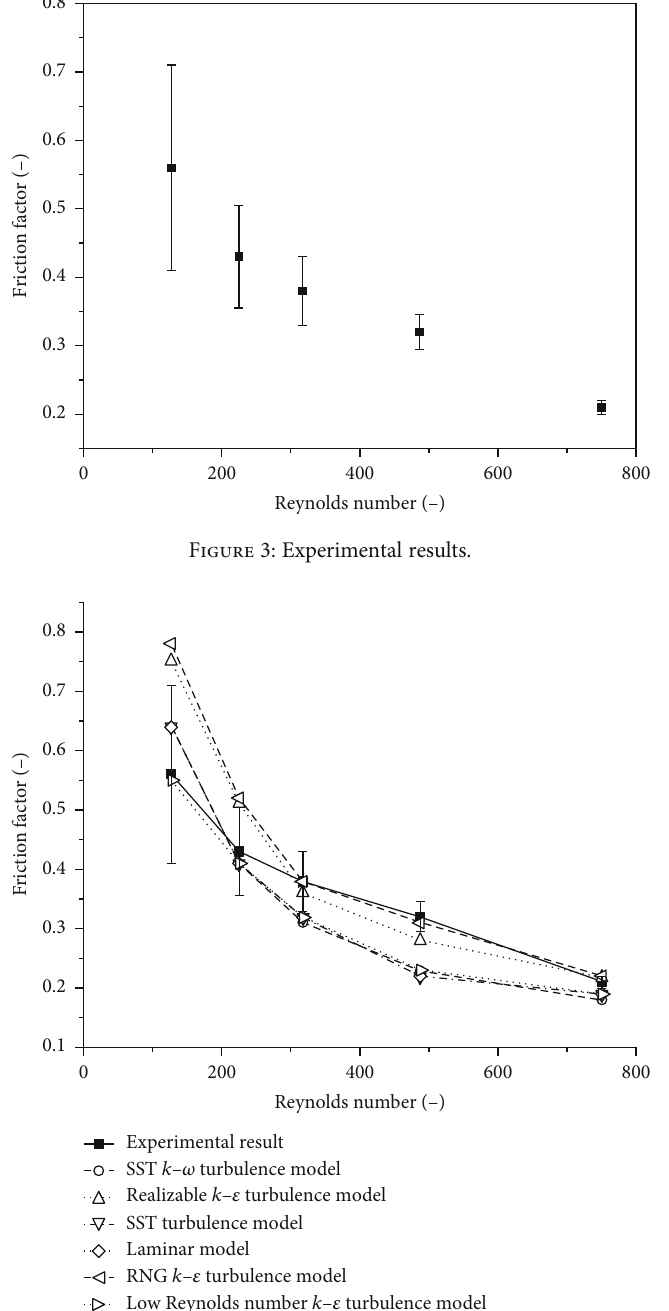
Figure 4: Calculation results of turbulence